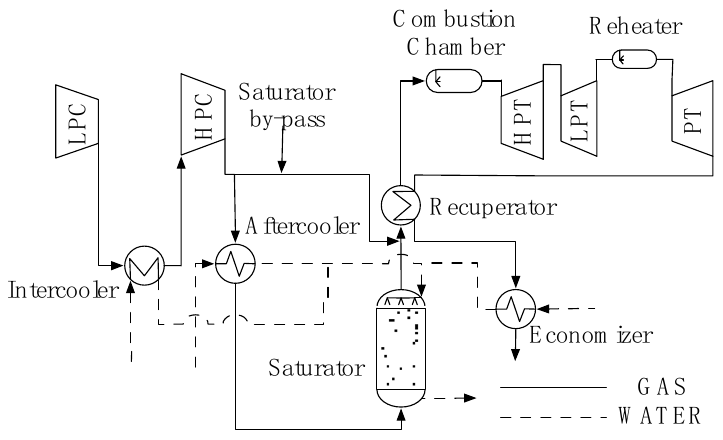
Figure 1. Schematic layout of the Humid Air Turbine.